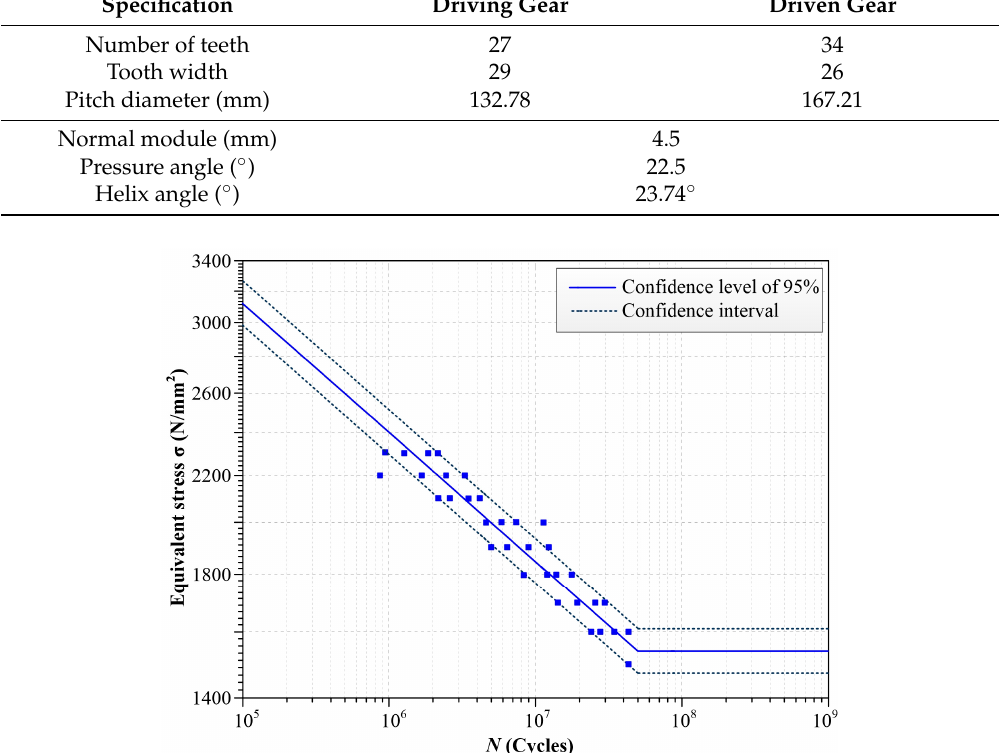
Figure 2. Stress ‐ number of cycles (S ‐ N) curve. Figure 2. Stress-number of cycles (S-N)